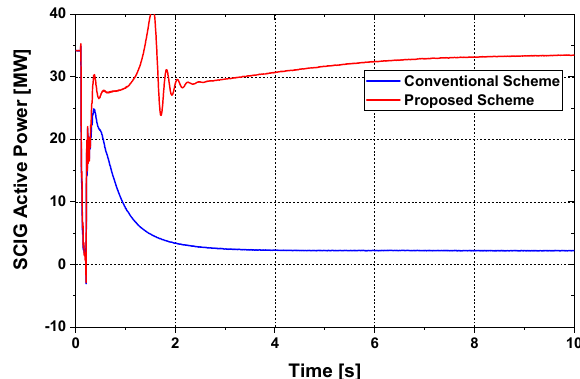
Figure 15. Active Power response of SCIG.